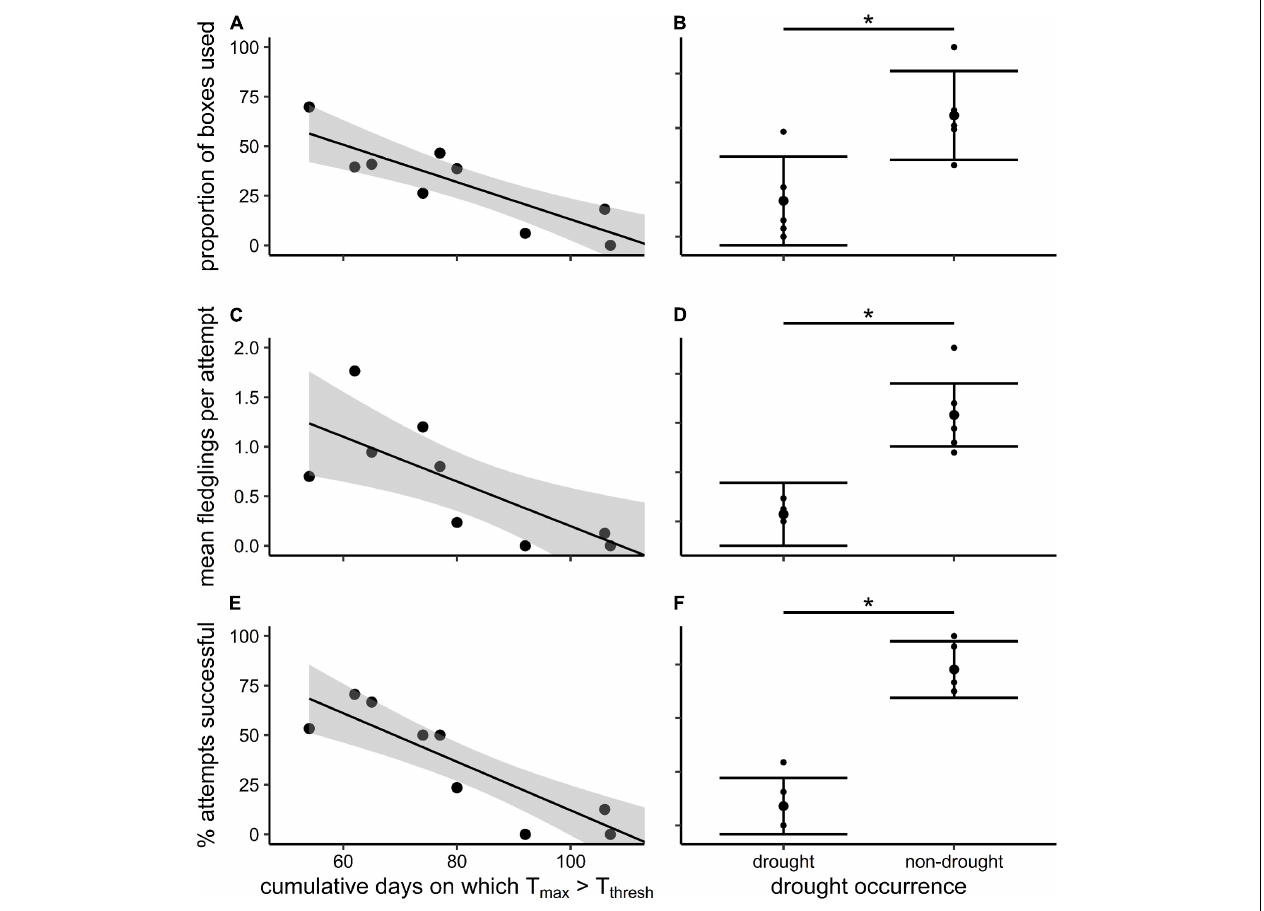
FIGURE 3 | (A,B) The percentage of boxes used, (C,D) the mean fledglings per attempt, and (E,F) the percentage of attempts that succeeded in the southern yellow-billed hornbills ( Tockus leucomelas ) as functions of the cumulative DaysT thresh {days on which T max [mean maximum daily air temperature (T air )] > T thresh (T air = 34.5 ◦ C)}, and occurrence of drought across the breeding season. All trends are significant ( p < 0.05), and 95% confidence intervals and means with upper and lower quartiles are shown.